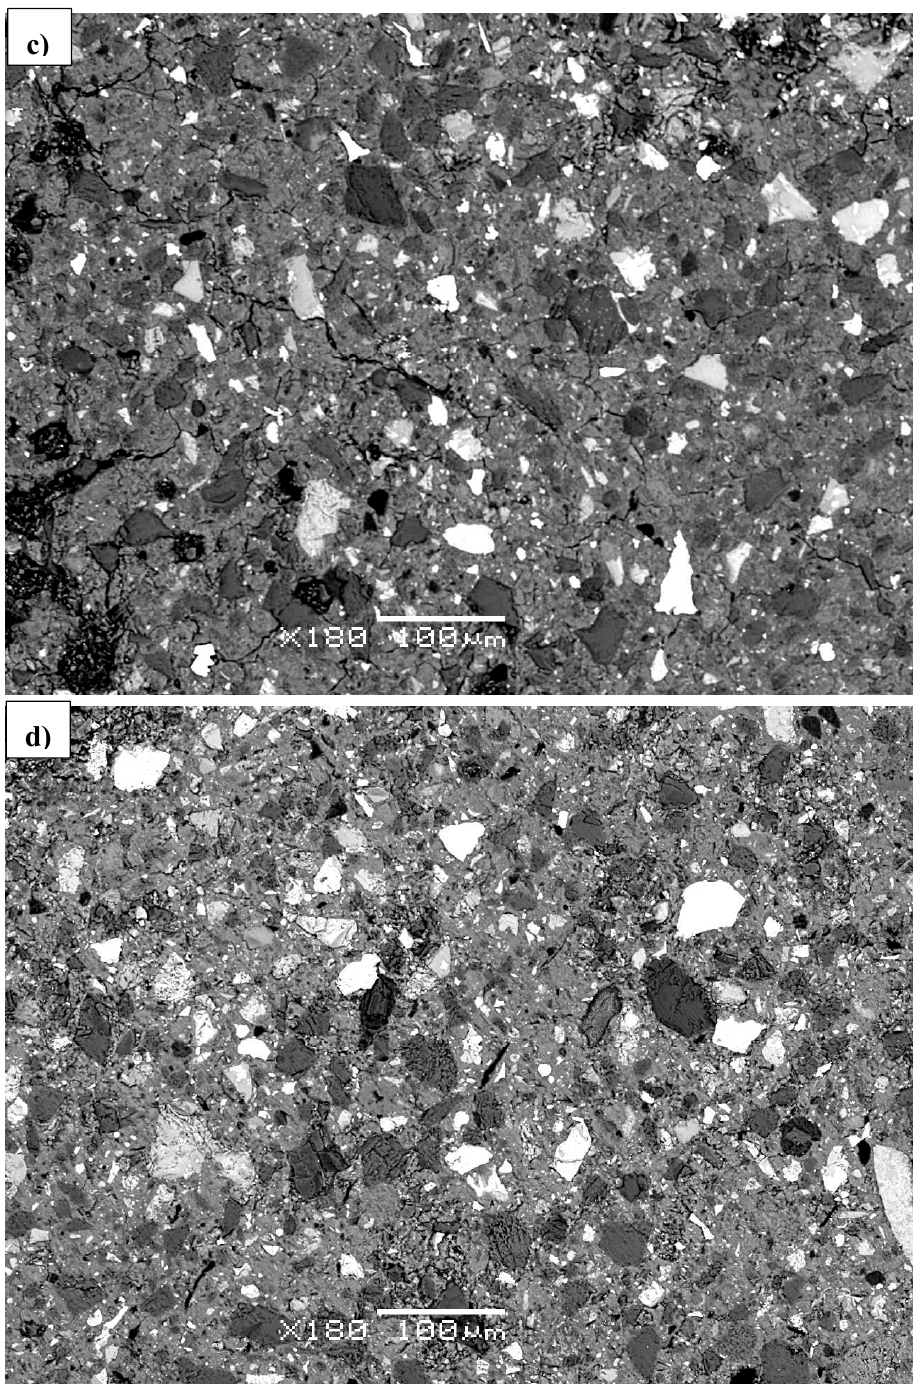
Figure 11. SEM images of A/R: 1/1 sample cured at: ( a ) R.T. (28 days) ( b ) 50 °C, 1 day, ( c ) 50 °C, 3 days, ( d ) 90 °C, 3 days.